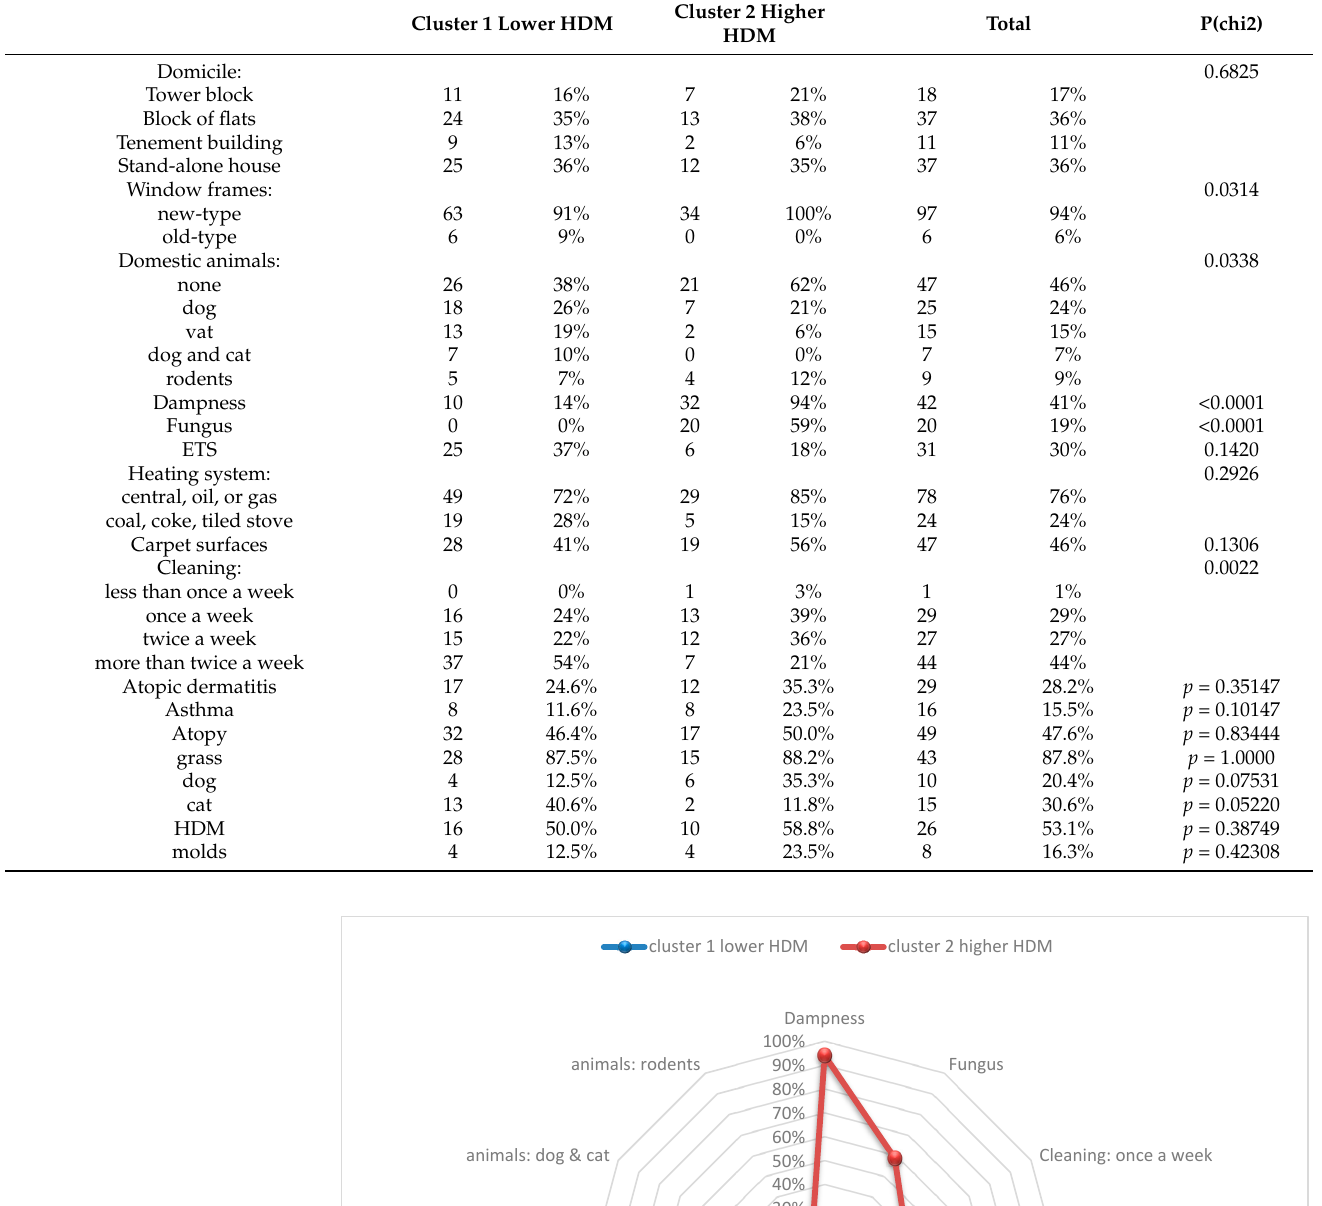
Table 5. Environmental exposure characteristics by clustering results.